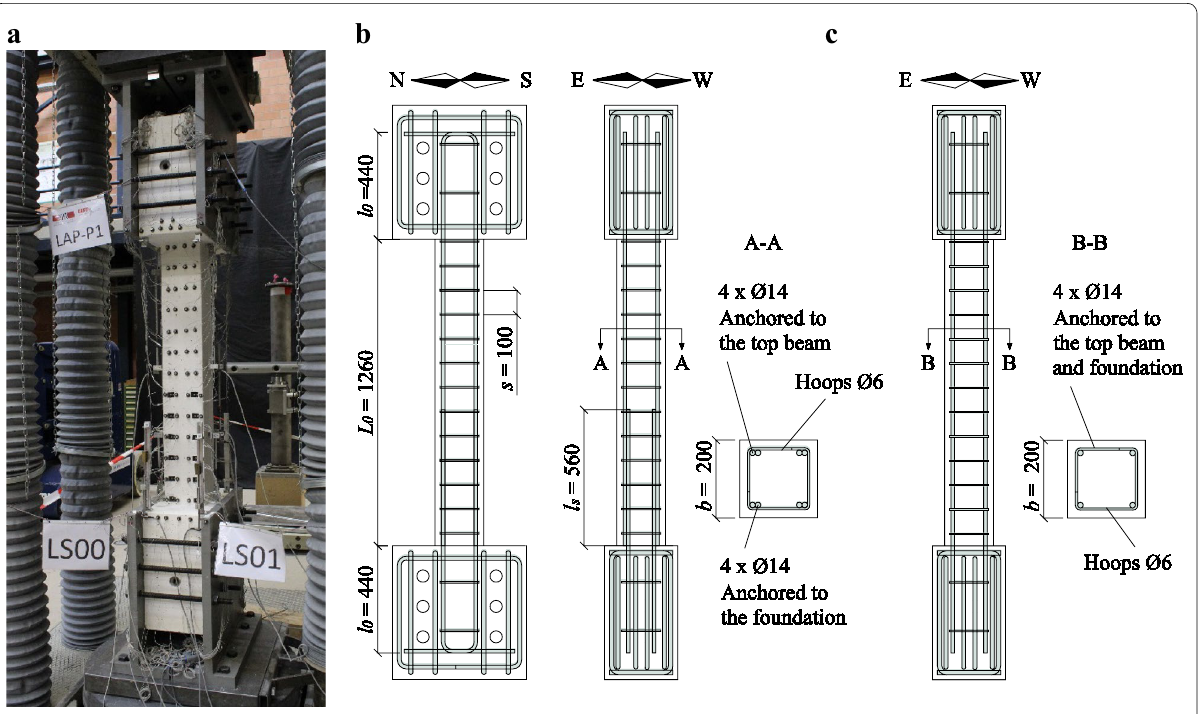
Fig. 8 Experimental programme used for model validation (Tarquini et al. 2018): a Photo of test unit LAP-P1 in test stand; Example of a reinforcement layout of ( b ) a TU with lap splices (LAP-P1); and ( c ) a TU with continuous reinforcement (LAP-C1).